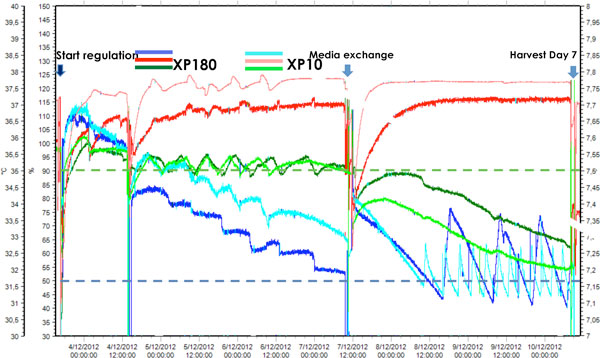
Regulation parameters in XP-10 (A) or XP-180 (B) in the course of time, pH (green), D.O. (blue) and T° (red) evolution. Set points (dashed lines) were fixed at 7.5 for pH and D.O. >50%. T° peaks are due to Xpansion disconnection for microscopic observation or samplings.